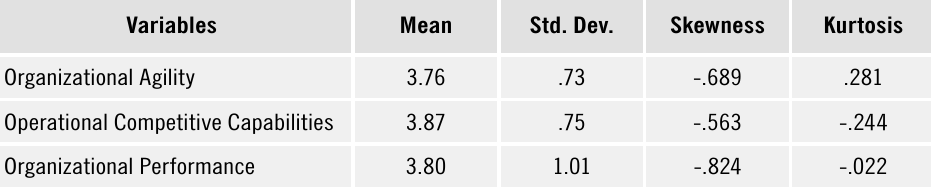
Table 3. Test of